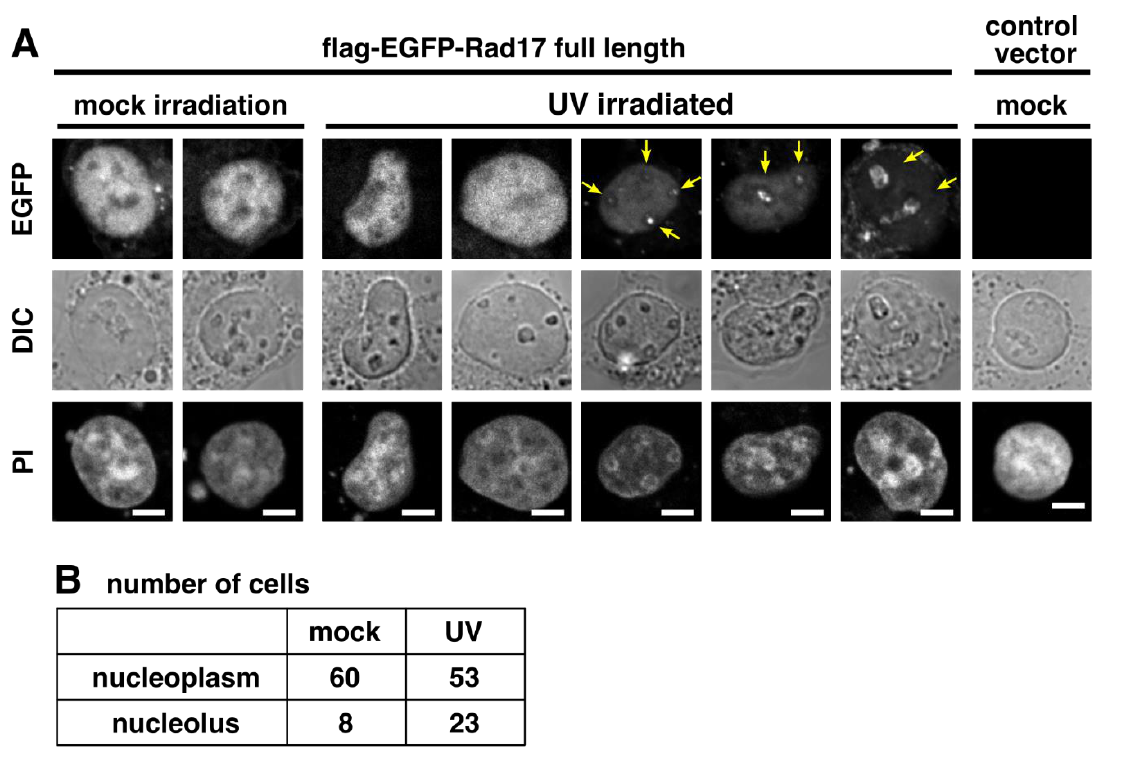
Figure 4. UV irradiation promotes nucleolar accumulation of flag-EGFP-Rad17 full-length protein. ( A ) COS-1 cells were transfected with flag-EGFP-Rad17 full-length. Forty-eight hours after transfec- tion, the cells were exposed to 30 J/m 2 UV-C and recovered for 3 h. The cells were fixed, and DNA was stained with propidium iodide (PI). Yellow arrows indicate nucleolar localization of the EGFP signal. DIC, differential contrast. Scale bars are 5 μm. ( B ) The number of cells with nucleoplasmic and nucleolar localization of flag-EGFP-Rad17 was counted in two independent experiments. The p -value was calculated with the chi-square test .